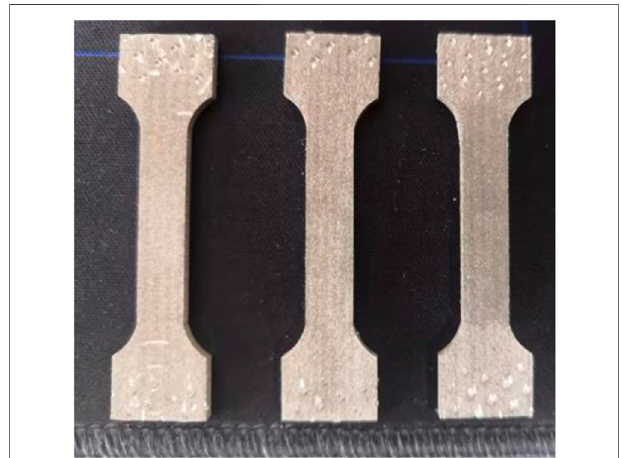
FIGURE 2 | Photos of samples.